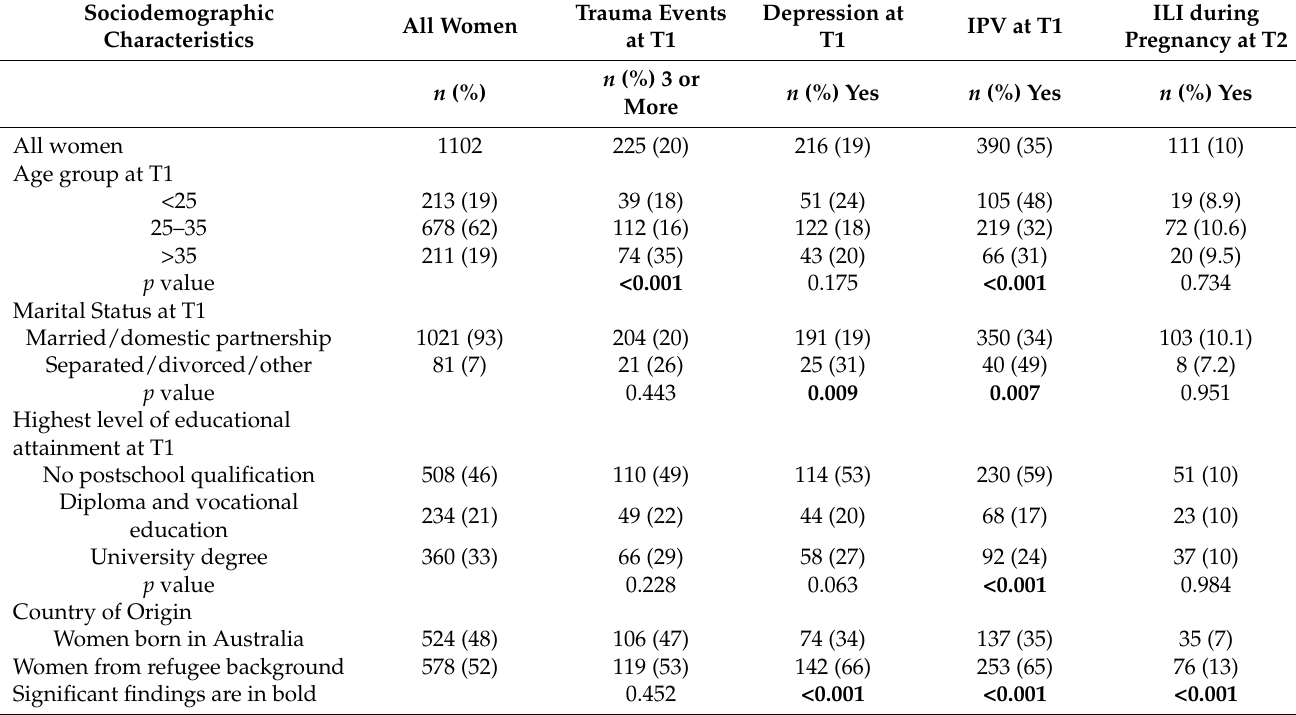
Table 1. Influenza-Like Illness in pregnancy and sociodemographic